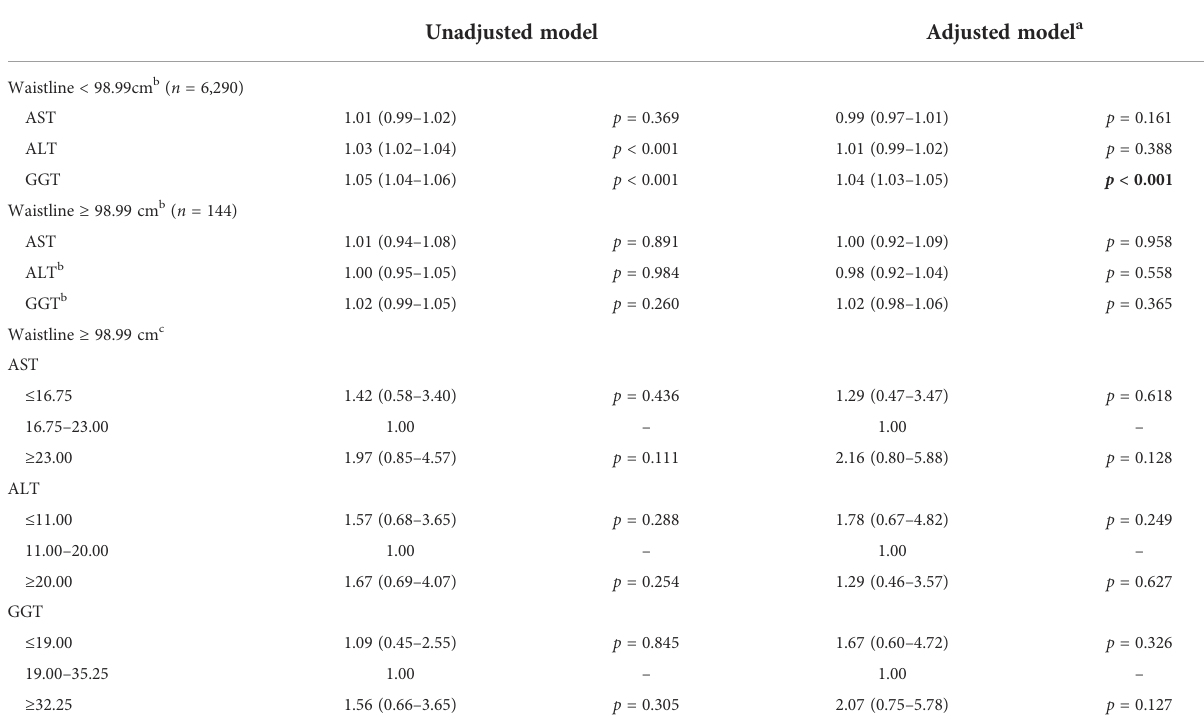
TABLE 3 Regression model of the relationship between liver enzymes and DM risk in WC subgroups. Liver enzymes category